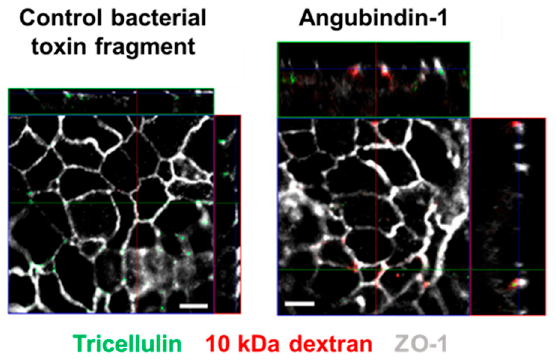
Figure 3. Visualization of the permeation of a macromolecule through tricellular TJs. HT-29/B6 cells were treated with control bacterial toxin fragment or angubindin-1 for 48 h. The cells were incubated with avidin and then with biotin-labeled tetramethylrhodamine-dextran 10 kDa (red) on the apical side of the insert for 1 h. The cells were then fixed and subjected to immunofluorescence analysis. The green signal represents tricellulin and the gray signal represents zonula occludens-1. Bars = 5 µ m. The figure is reproduced from reference [50] with slight modifications and permission from the copyright